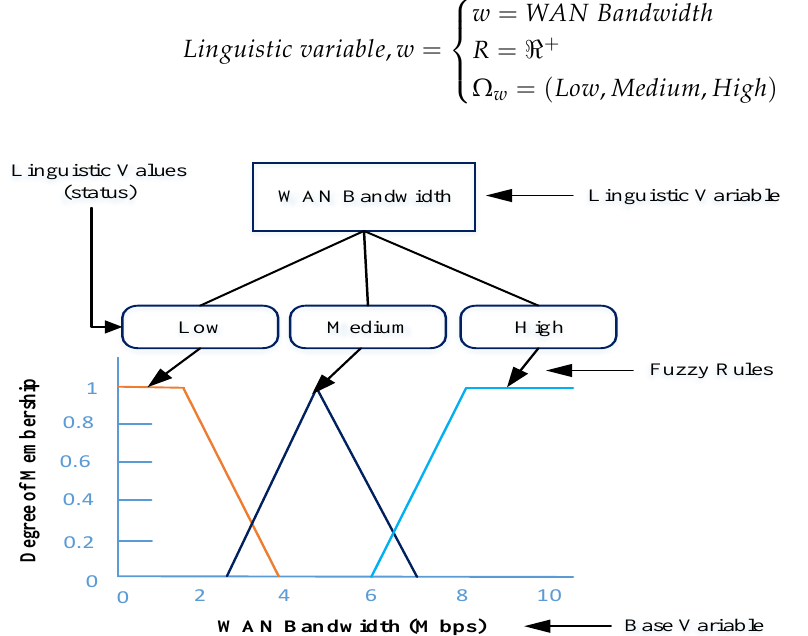
Figure 7. Example of linguistic variables for WAN